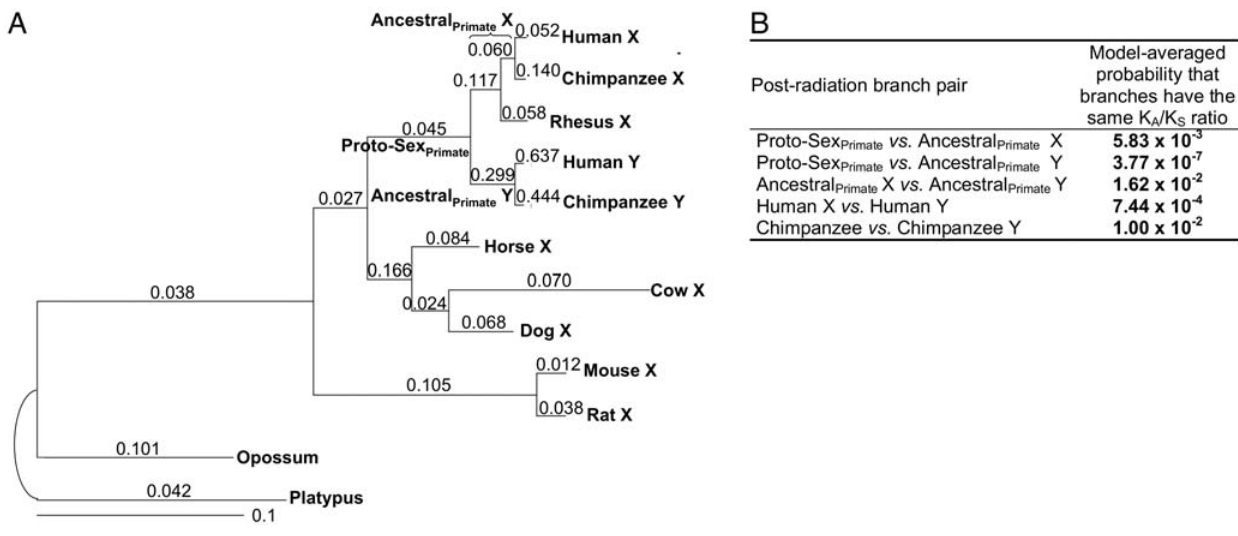
Figure 3. Post-radiation phylogeny and evolutionary rate comparisons. (A) Phylogeny for the post-radiation topology. Exons with less than 50% bootstrap support for clades with either the pre- or post-radiation topology, fewer than 24 nucleotides aligned across all species, or inconsistent with the topology of the whole gene were excluded. Branch lengths are proportional to the estimated synonymous substitutions per site, and are labeled with the nonsynonymous-to-synonymous rate ratios (K A /K S ). (B) Branch length comparisons for the post-radiation topology. We present the model-averaged probabilities (not P values) that two branches have the same Ka/Ks ratio, and so corrections for multiple tests are neither needed nor appropriate (see Materials and Methods). Significant values are shown in bold.